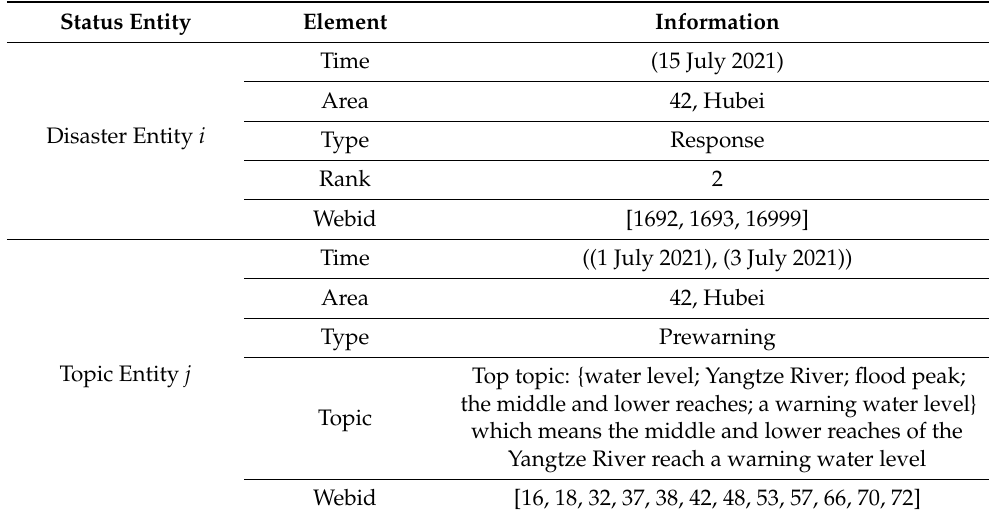
Table A3. Element information of examples of disaster status and topic status entities of Hubei